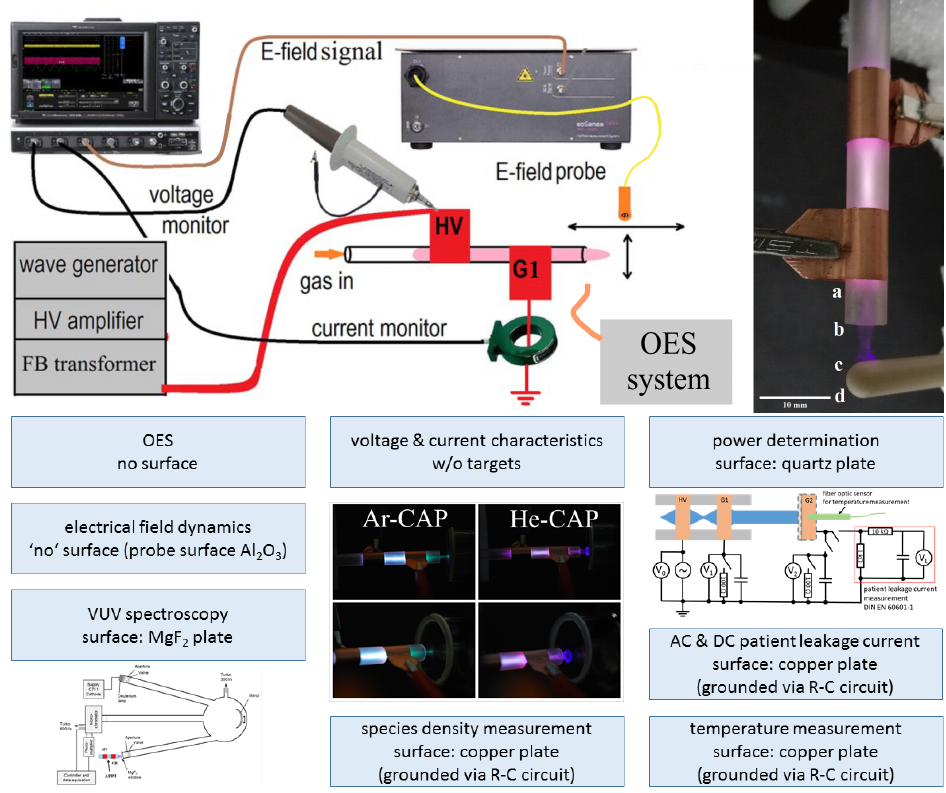
Figure 1. Overview of the experimental arrangements: ( top ) CAP, E-field and VUV set-up with a photo of the CAP and E-field probe; ( bottom ) CAP facing the VUV MgF 2 window with a list of performed diagnostics throughout the manuscript and the description of w/o surface. Leakage current circuit in accordance with